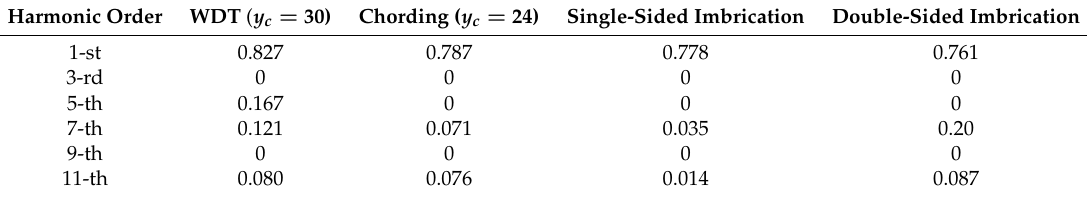
Table 23. Winding factor harmonics with different optimization techniques for N = 60, p = 1 and m =